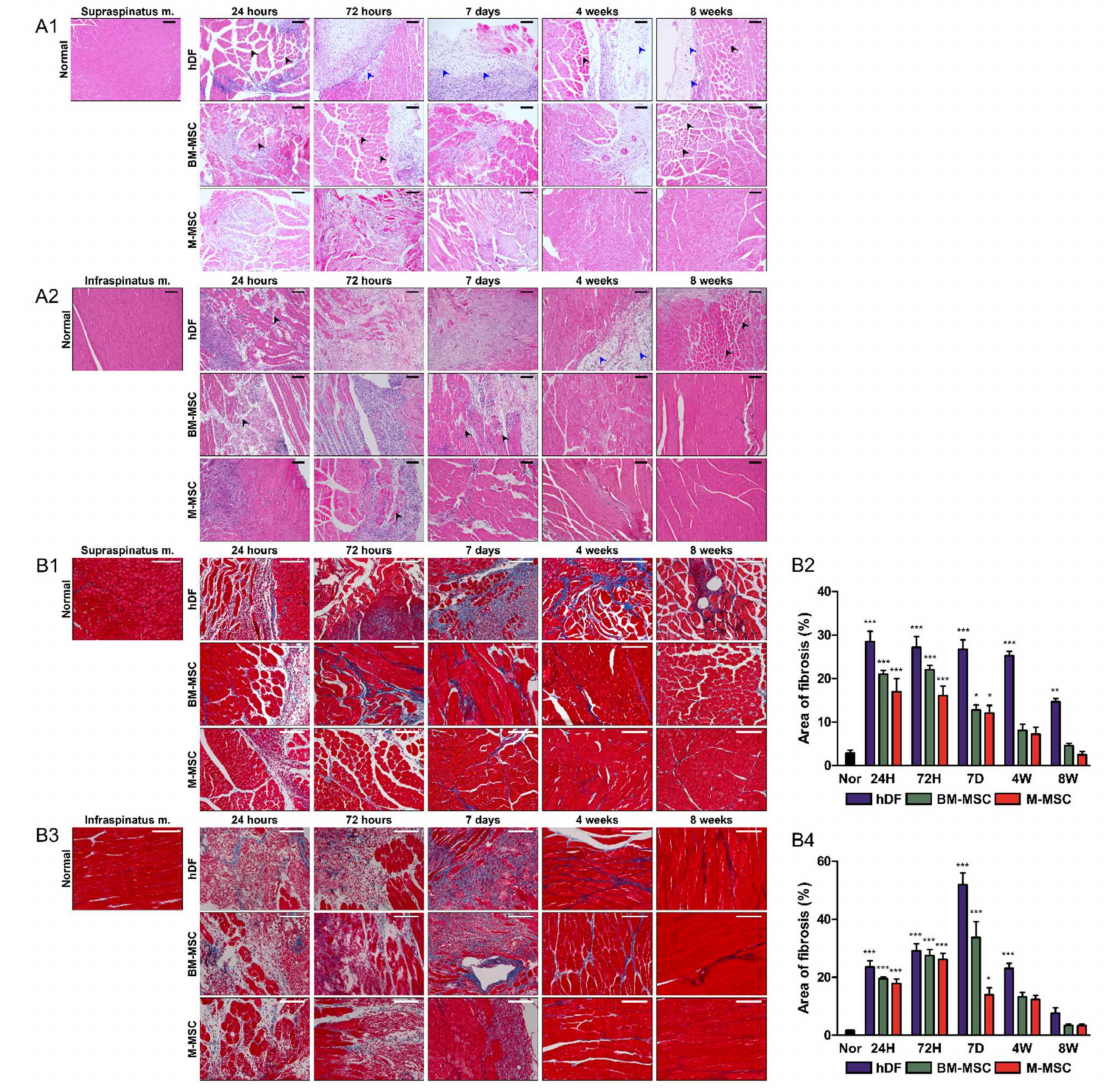
Figure 3. Morphological evaluation of H and E and MT-stained slides. For histopathological analysis, muscle samples were excised from hDF (control), BM-MSC and M-MSC groups at 24 h, 72 h, 7 days, 4 weeks, and 8 weeks after RCT induction. ( A1 ) Supraspinatus and ( A2 ) infraspinatus muscles were stained with hematoxylin and eosin. Black arrows indicate atrophy, and blue arrows indicate fat infiltrates. The scale bars are 100 µ m. To quantify the fibrotic area, ( B1 , B2 ) the supraspinatus and ( B3 , B4 ) the infraspinatus muscles were stained with Masson’s trichrome. The scale bars are 100 µ m. ( B2 , B4 ) The areas of fibrosis were determined as blue and were quantified in three random high-power fields (HPFs) per sample. The data are shown as mean ± SD and the significance was represented as * p < 0.05; ** p < 0.01; *** p < 0.001,